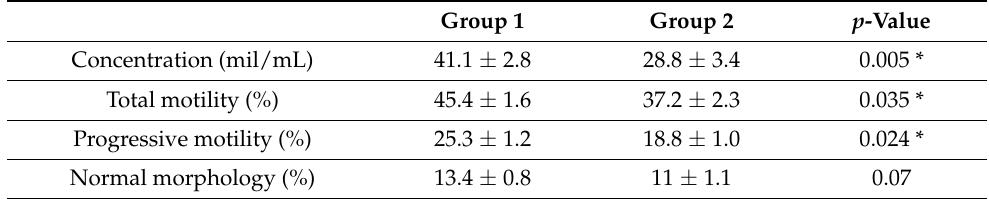
Table 2. Sperm parameters (mean ± SEM) of patients of Groups 1 ( n = 223) and 2 ( n = 90).